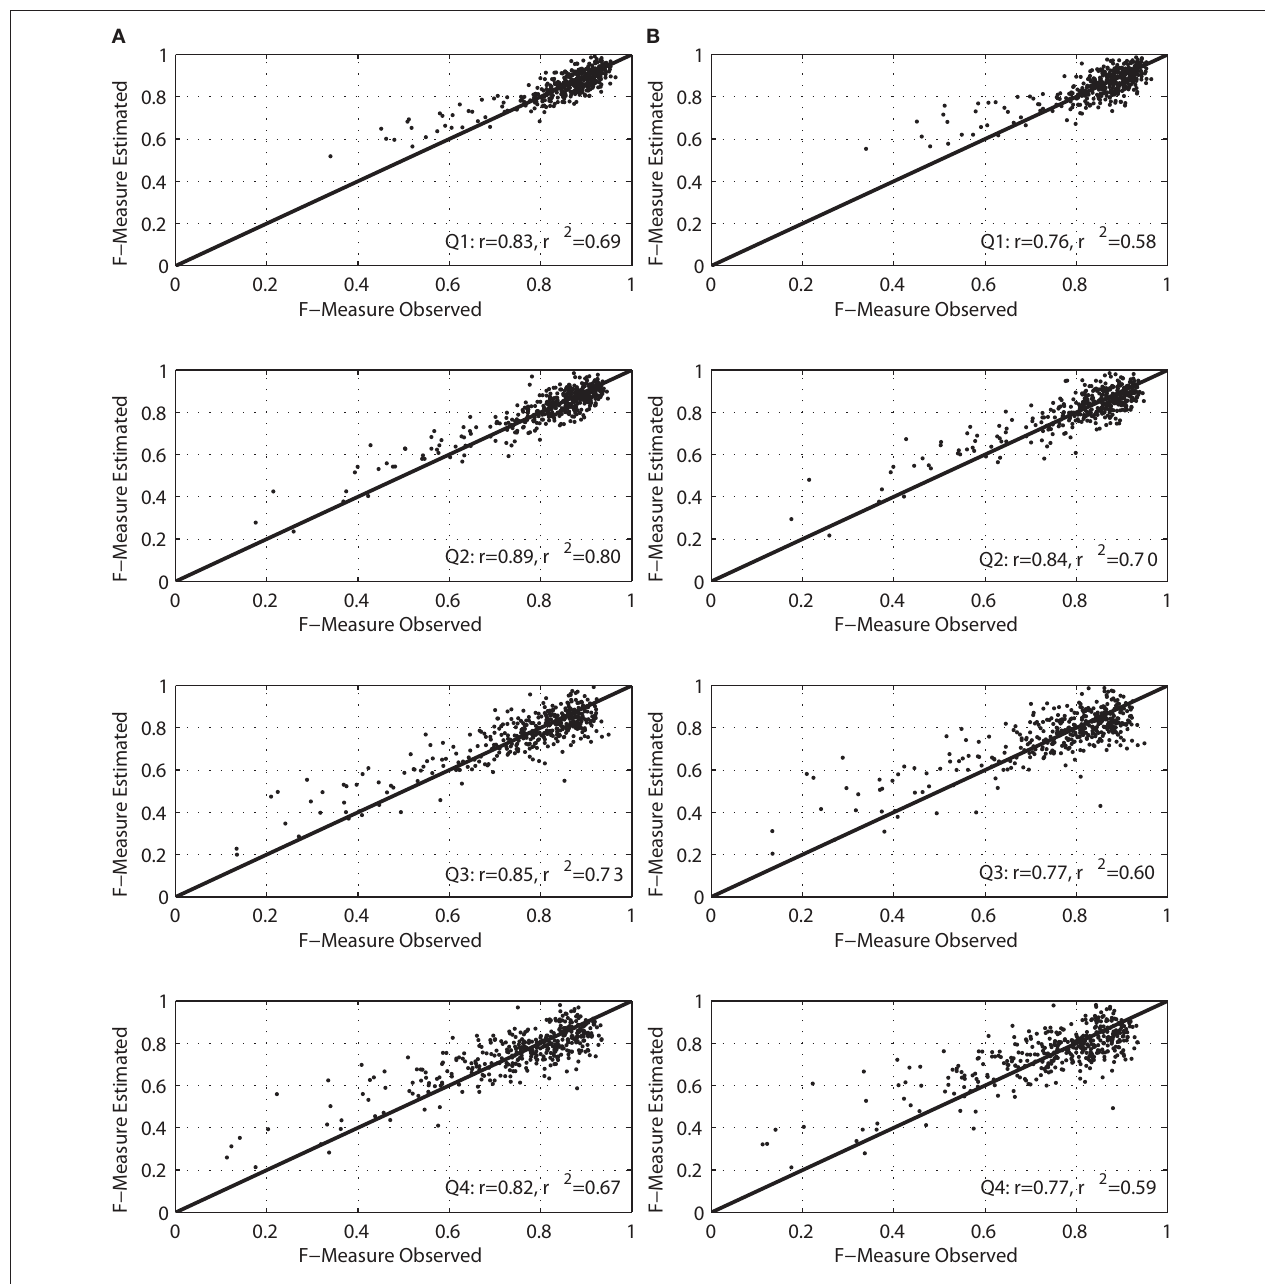
Figure 3 | Correlation plots between observed and estimated F -Measure for present performance by quartile. (A) The model development results, and (B) the